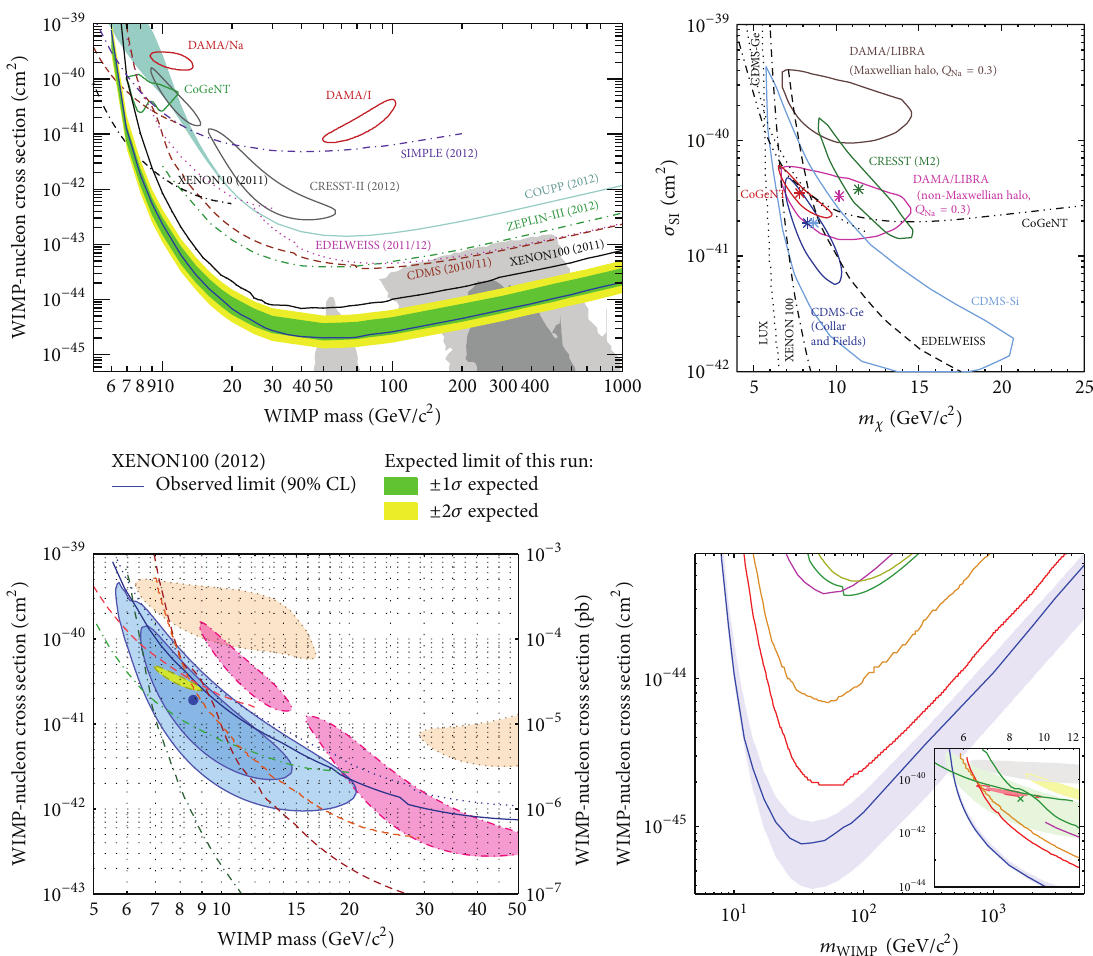
Figure 2: A compilation of the allowed regions and the constraints for the “standard” SI contact interaction in the ( 𝑚 𝜒 ,𝜎 the top row are taken from [53] (left) and from [46] (right), while those in the bottom row are taken from [51] (left) and from [54] (right). The galactic halo has been assumed in the form of an isothermal sphere with velocity dispersion V 0 = 220 km/s and local DM energy density = 0.3 GeV/cm 3 𝜌 ⊙